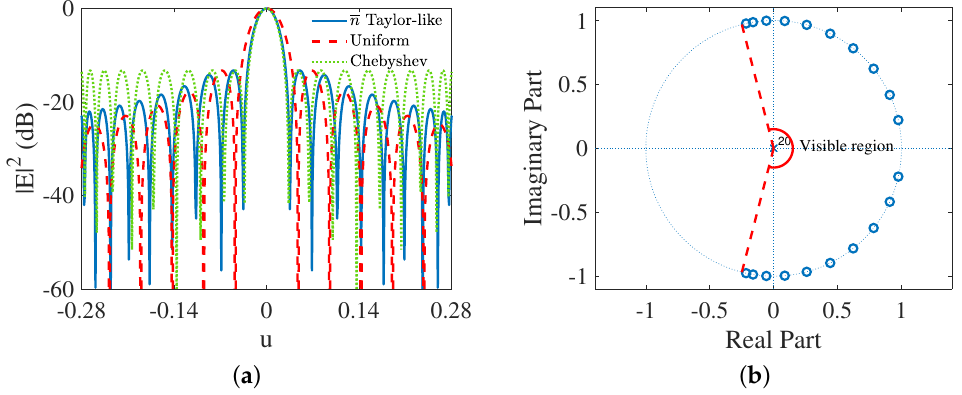
Figure 4. ( a ) Simulated 21-element Taylor-like super-directive pattern where n = 3 (blue line), Chebyshev super-directive pattern (green dotted line) and the reference uniform pattern (red dashed line) with the same element spacing, d = 0.29 λ . ( b ) The zeros distribution of the Taylor-like super- directive pattern on the complex unit